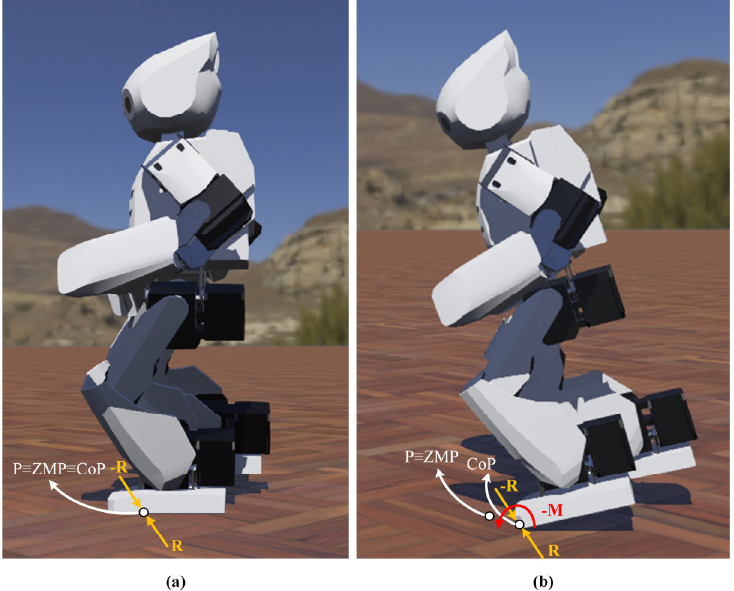
Figure 9. Relationship between ZMP and CoP: ( a ) dynamically stable gait, ( b ) dynamically unsteady gait.